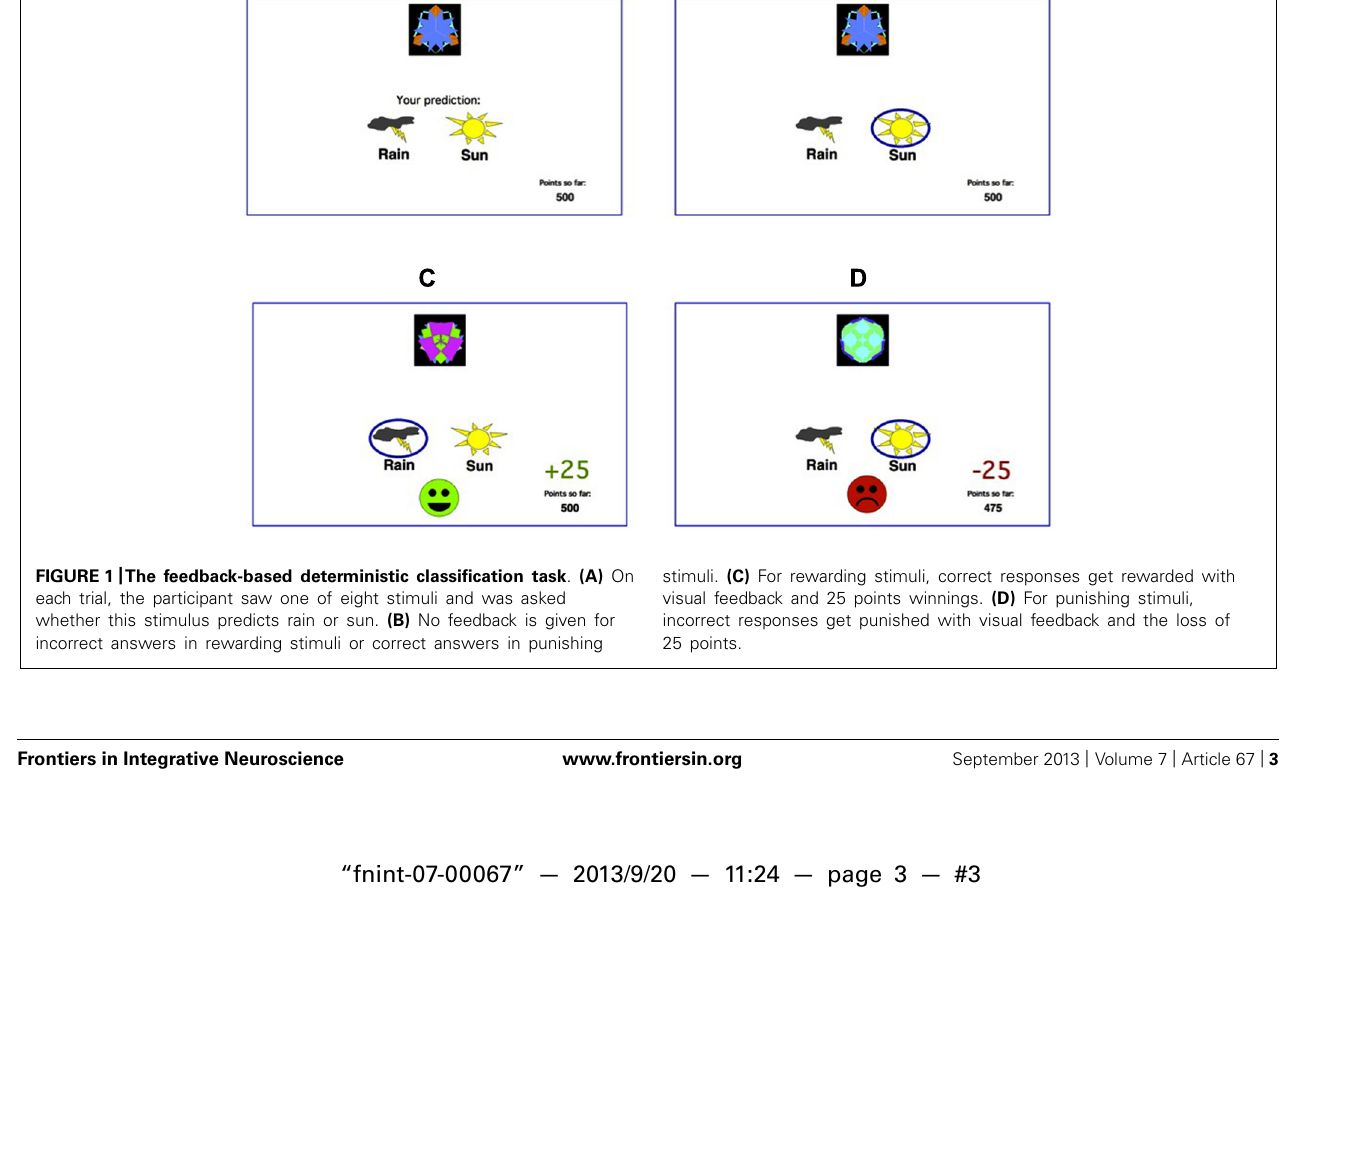
stimuli. (C) For rewarding stimuli, correct responses get rewarded with visual feedback and 25 points winnings. (D) For punishing stimuli, incorrect responses get punished with visual feedback and the loss of 25